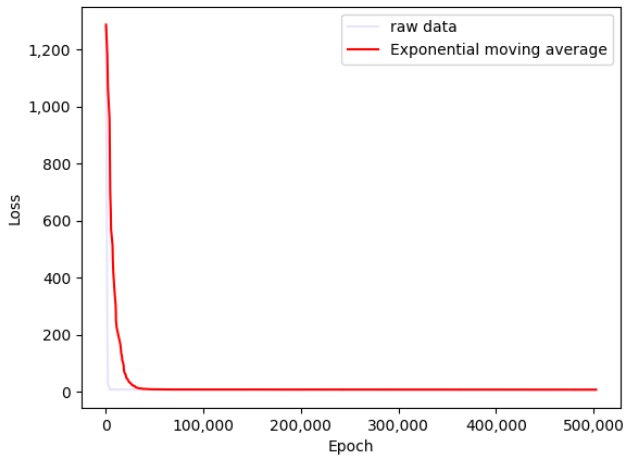
Figure 15. Loss function of experiment LSTM